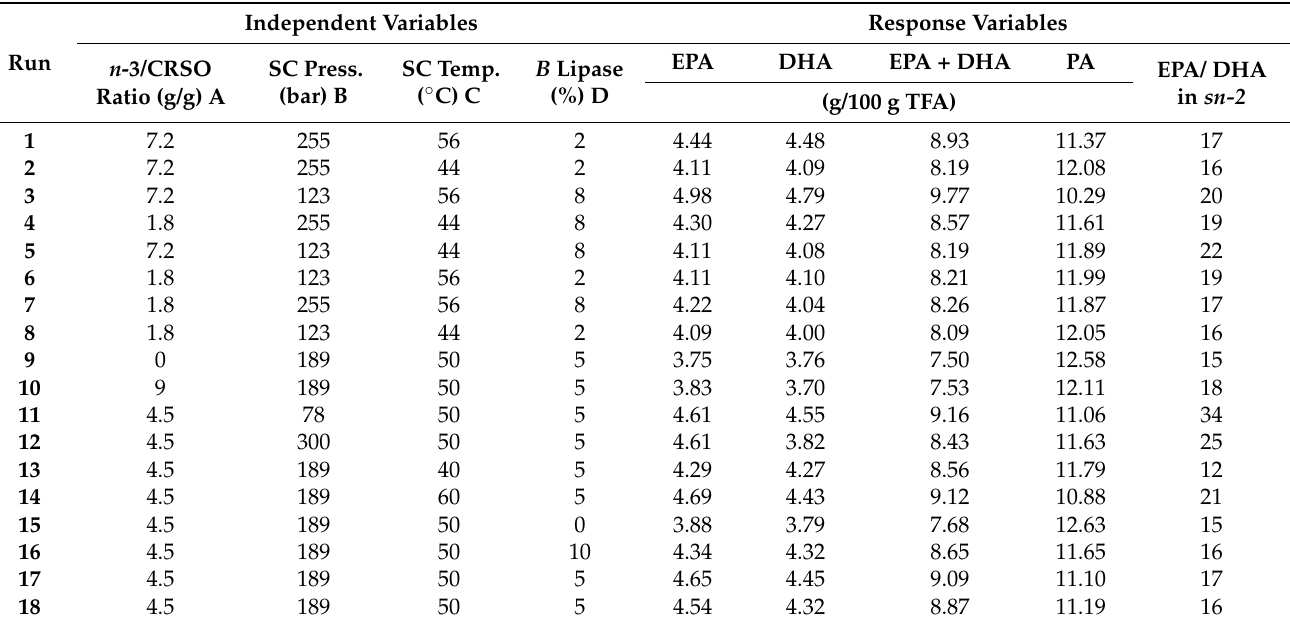
Table 1. Draper-Lin composite design by RSM. Tests for optimizing the conditions for obtaining the structured acylglycerol (SAcyl)